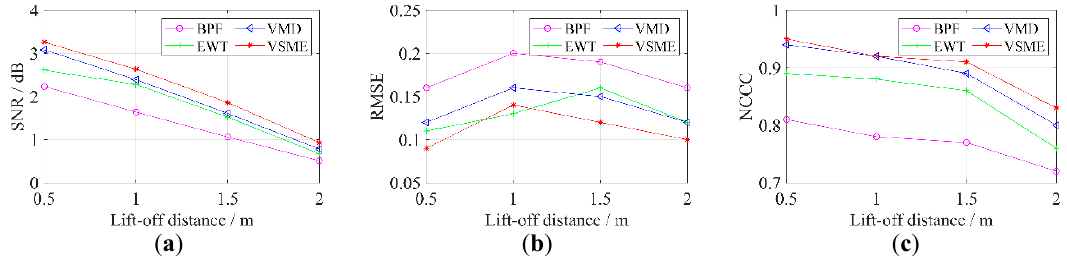
Figure 11. Performance evaluation for the defect signals at different lift-off distances. ( a ) SNR plot, ( b ) RMSE plot, ( c ) NCCC plot.